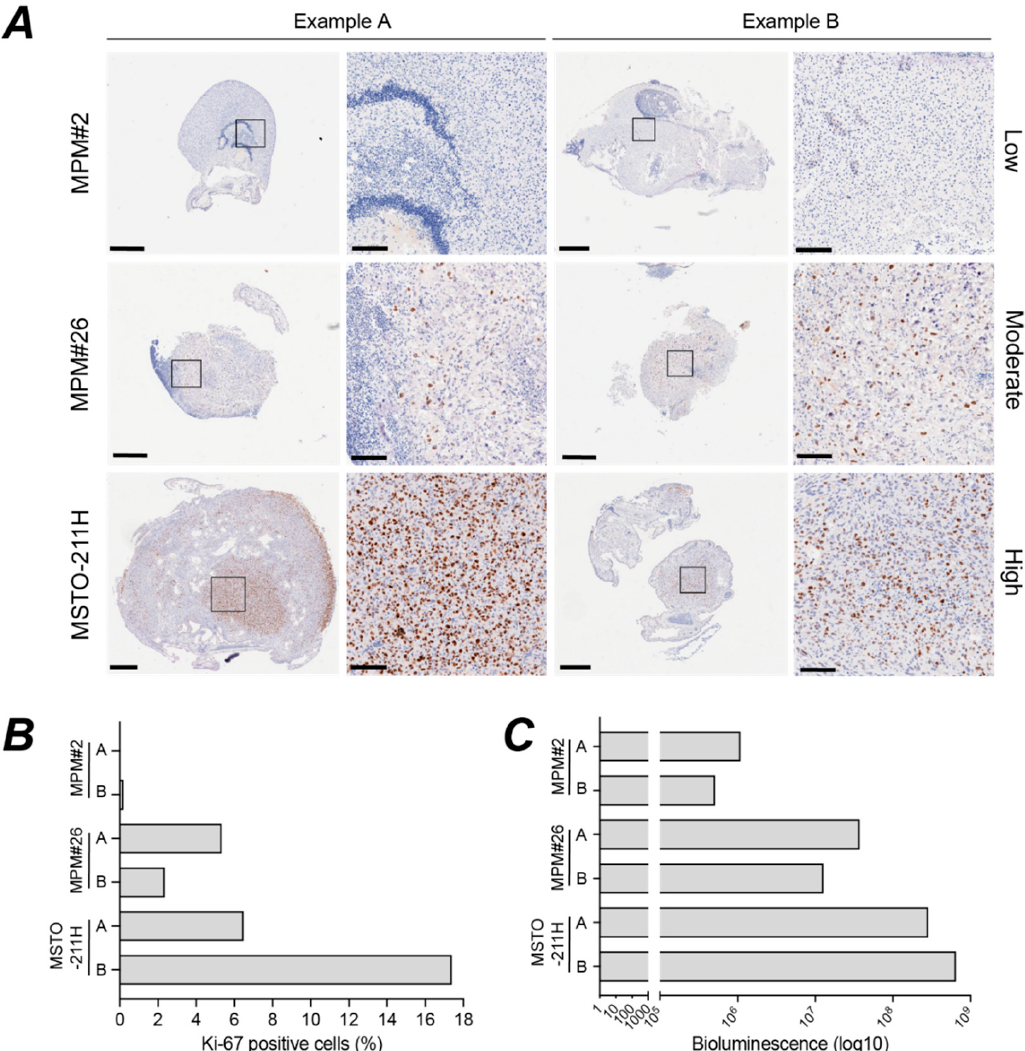
Figure 9. Bioluminescence signal corresponds closely with Ki-67 staining for proliferating cells. ( A ) Ki-67 staining of two independent MPM nodules for each of three MPM cell lines chosen as examples of low, moderate, and high staining. Whole tumour nodules (left, scale bar 500 µ m) and higher magnification of regions (right, scale bar 100 µ m). Supporting IHC for other markers in Figure S8. ( B ) Ki-67 score determined by Qupath analysis of images show in A ( n = 2). Supporting data in Figure S9A. ( C ) Corresponding bioluminescence signal for the tumours shown in A ( n = 2). Pearson correlation between Ki-67 score and bioluminescence, r = 0.96, p = 0.0023. Supporting data in Figure S9B. All experiments were in ovo